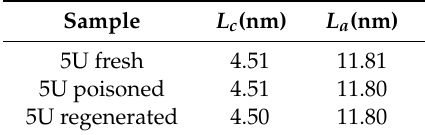
Table 2. The lateral size ( L a ) and stacking height ( L c ) parameters for selected